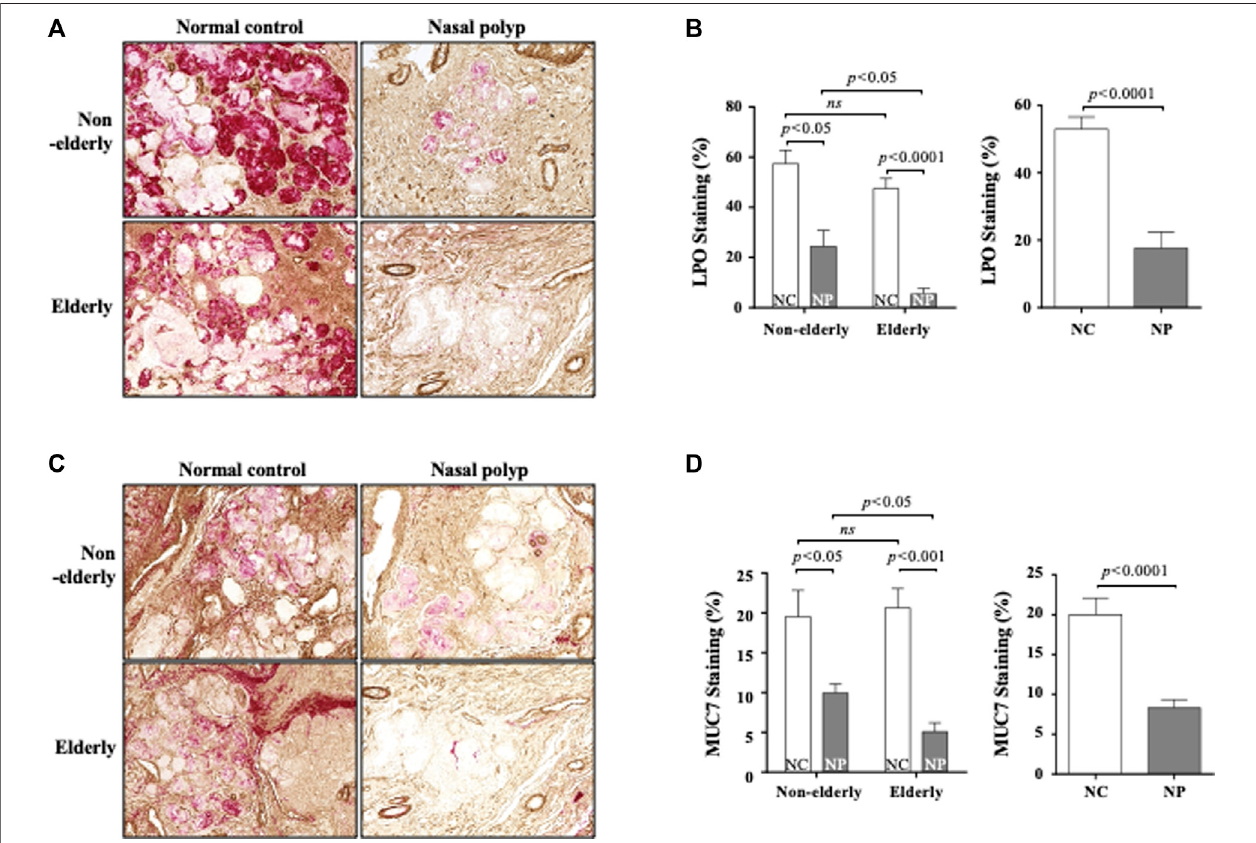
FIGURE4| ImmunohistochemistryofLPOandMUC7inthesinonasaltissuesfromsubjectswithNPandnormalcontrols.DatashowrepresentativeimagesofLPO (A) and MUC7 (C) immunohistochemistry staining (red color). Each staining was double stained with α SMA for clarifying glandular structure (brown color). Original magni fi cation ×100. Quanti fi cation of LPO (B) or MUC7 (D) -stained integrated density (%) per high power fi eld of each group. Data are expressed as the means ± SE (non-elderly NP versus elderly NP, n = 15, p < 0.05; NC versus NP, n = 33, p < 0.0001, respectively) (B,D) . NC, normal control; NP, nasal